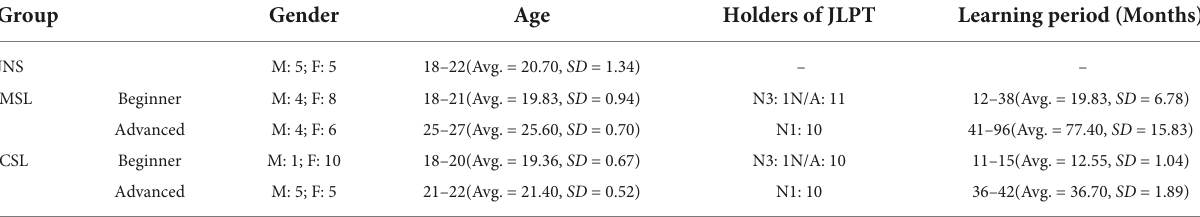
TABLE 1 Overall characteristics of participants in the perception